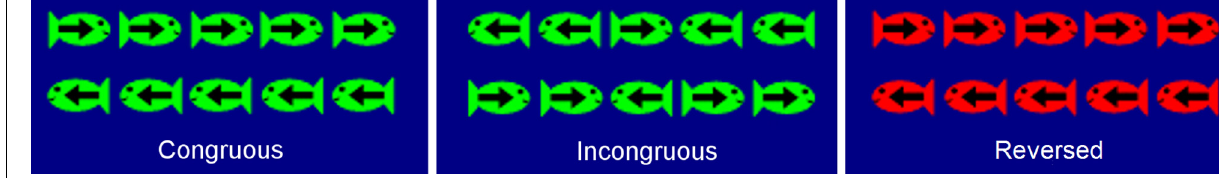
FIGURE 1 | The six flanker task stimuli used in the present experiment.